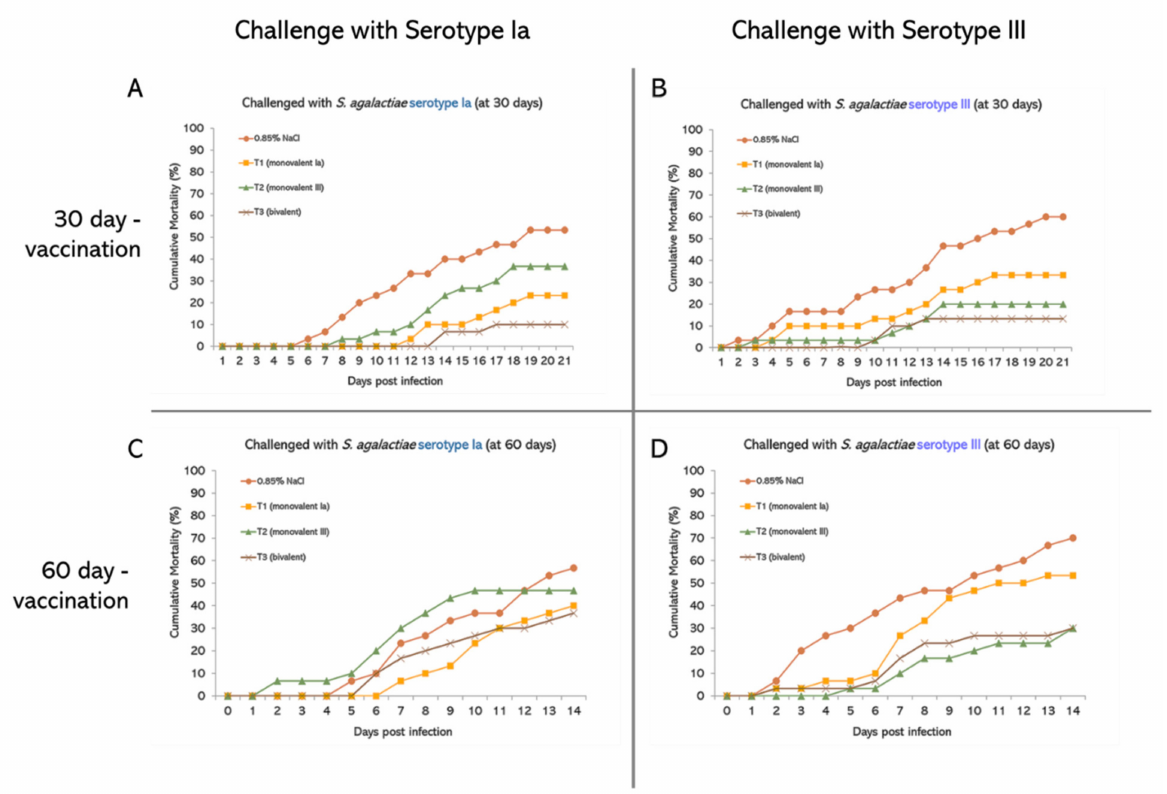
Figure 4. Mean cumulative mortality (%) of Nile tilapia ( Oreochromis niloticus Linn.) immunized with formalin-inactivated vaccine and challenged with S. agalactiae serotypes Ia and III at 30 and 60 days post-vaccination. ( A ) Challenged with S. agalactiae serotype Ia at 30 days, ( B ) challenged with S. agalactiae serotype III at 30 days, ( C ) challenged with S. agalactiae serotype Ia at 60 days, and ( D ) challenged with S. agalactiae serotype III at 60 days ( n =